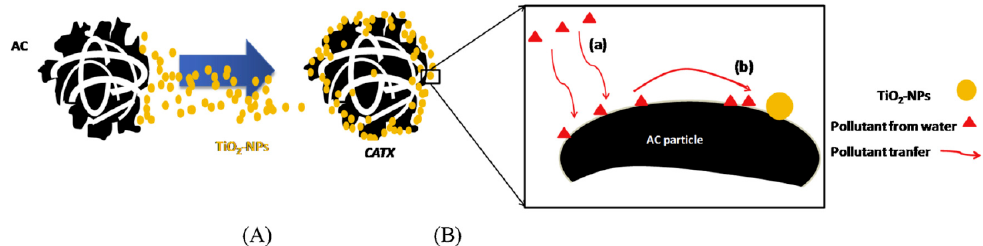
Figure 9. Scheme of ( A ) TiO 2 impregnation at the external porosity of AC support by surface coating (CATX, X referred to %wt of TiO 2 ) and ( B ) pollutant transfer towards photocatalytic center [87]. Reproduced with permission from Elsevier, 2022. Table 5. Photodegradation reaction involving Fe 3+ -TiO 2 -Zeolite nanocomposite [88] .